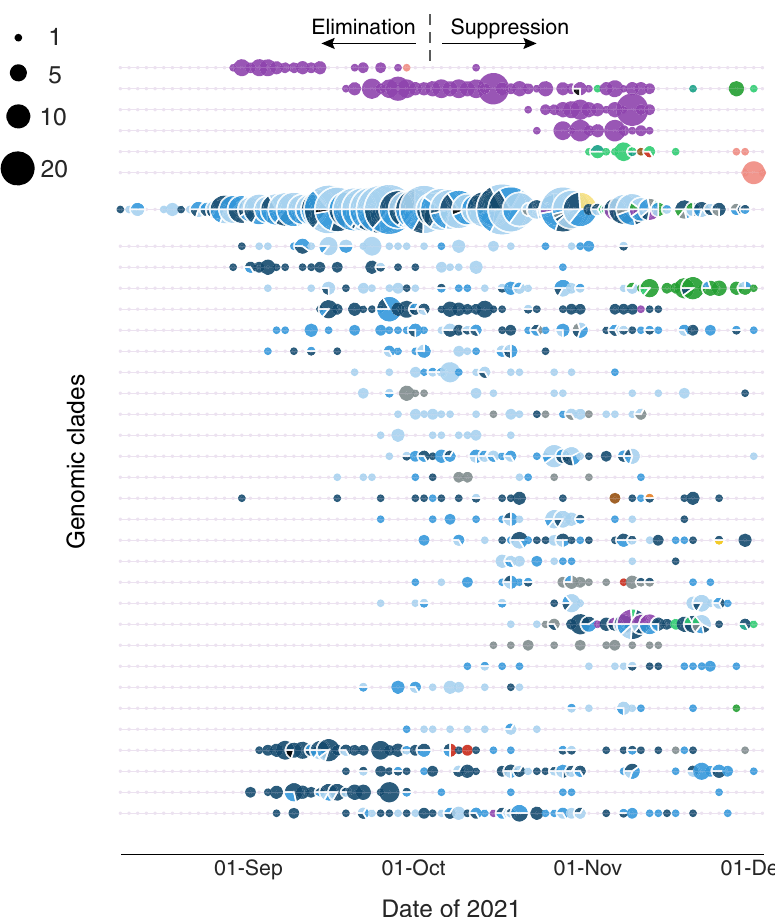
Fig. 2 Active genomic clades during the Delta SARS-CoV-2 outbreak. Bead plot showing a summary of active genomic clades per day between 17 August and 1 December 2021 coloured by the geographical region (District Health Board) shown in Fig. 1a. Each string of beads represents a genomic clade, and the size of each bead corresponds to the number of reported cases per day within each clade. Genomic clades were de fi ned as involving at least one single nucleotide polymorphism (SNP) and including at least 10